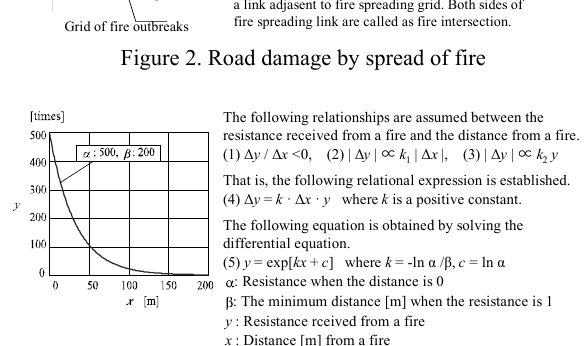
Figure 3. Resistance which evacuees receive from a fire